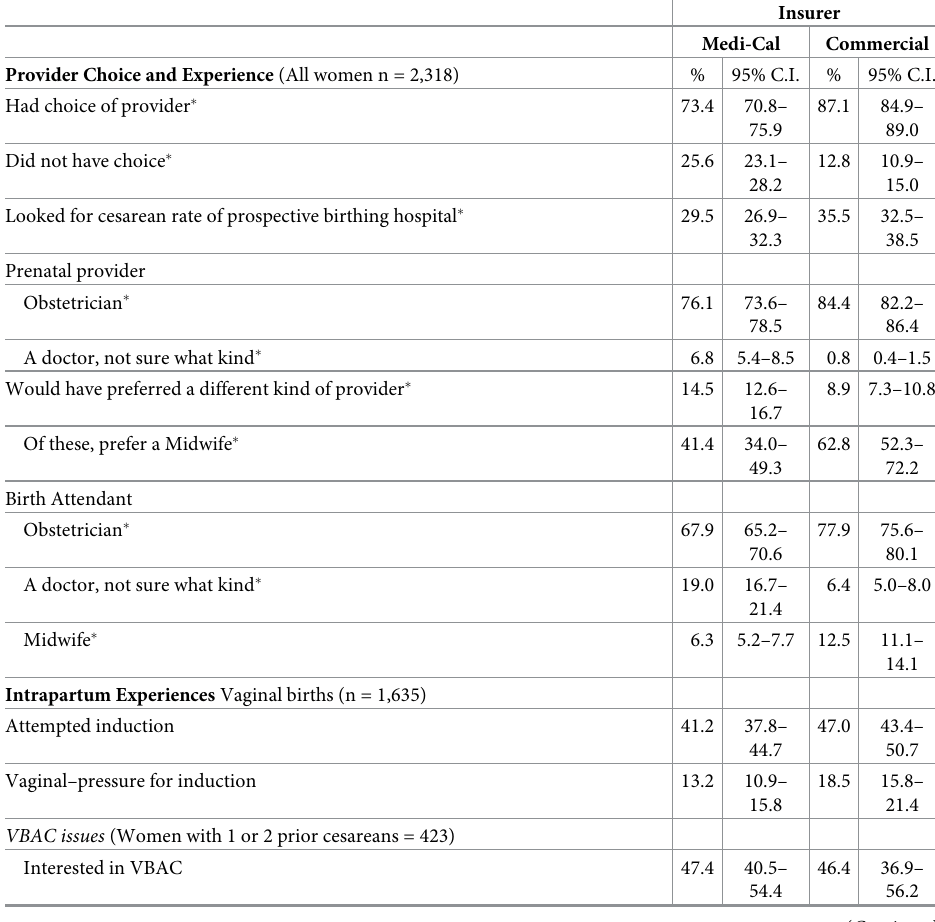
Table 2. Maternal experiences and attitudes toward birth, by type of